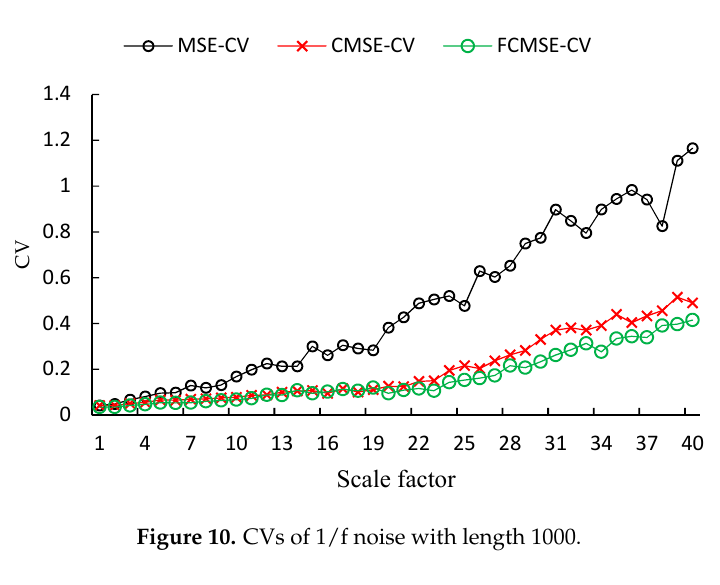
Figure 9. CVs of white noise with length 10000.